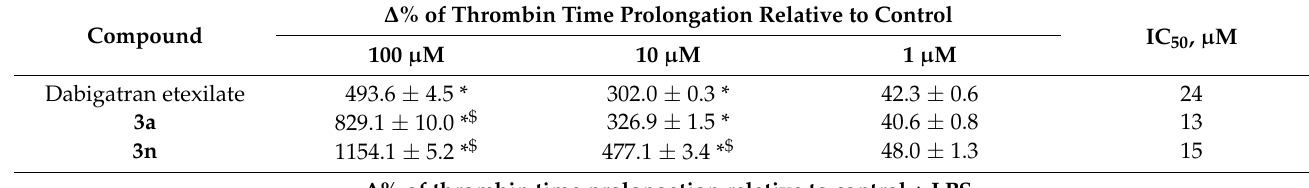
Table 5. IC 50 of compounds 3a and 3n of thrombin time prolongation with and without LPS in